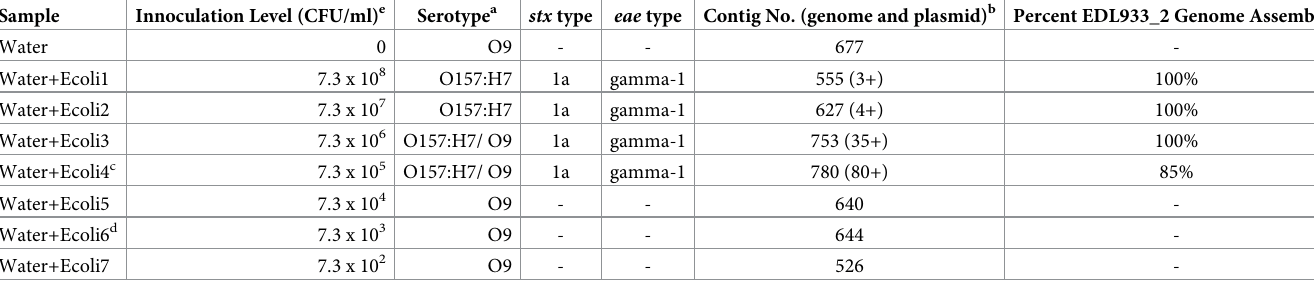
a in silico serotype using genes defined by the Center for Genomic Epidemiology at the technical University of Denmark (DTU) (https://cge.cbs.dtu.dk/services/ SerotypeFinder/). b In parenthesis, the number of contigs that contain the entire chromosome, a plus sign (+) indicates the presence of a contig that matched the EDL933_2 circular plasmid. c fragmented genome assembly